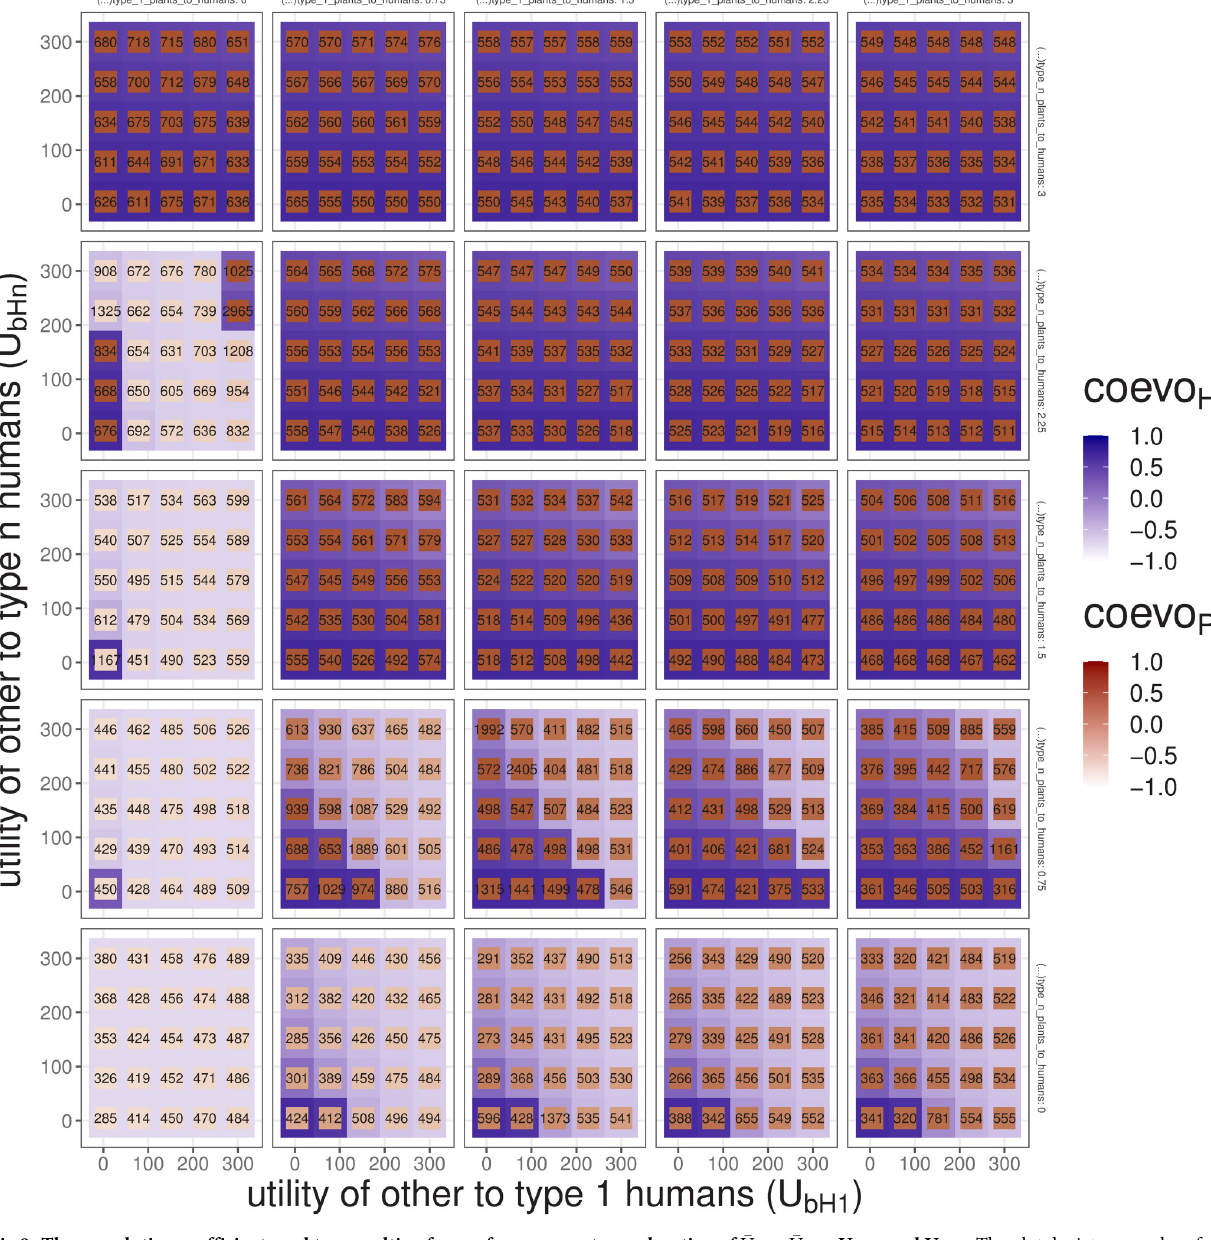
, � U , U bH1 , and U bHn . The plot depicts examples of P 1 H P n H